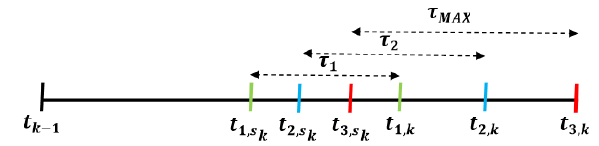
Figure 2. Possible transmission instant t